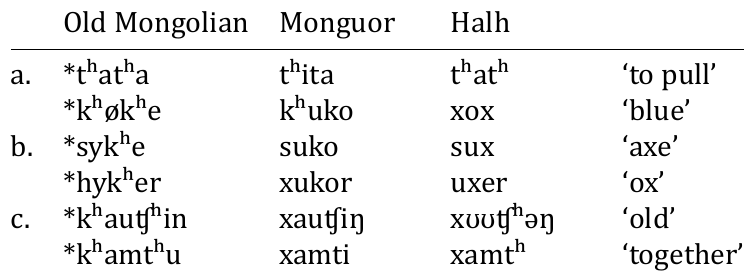
Table 2: The pattern of completed, progressive dissimilation in Monguor